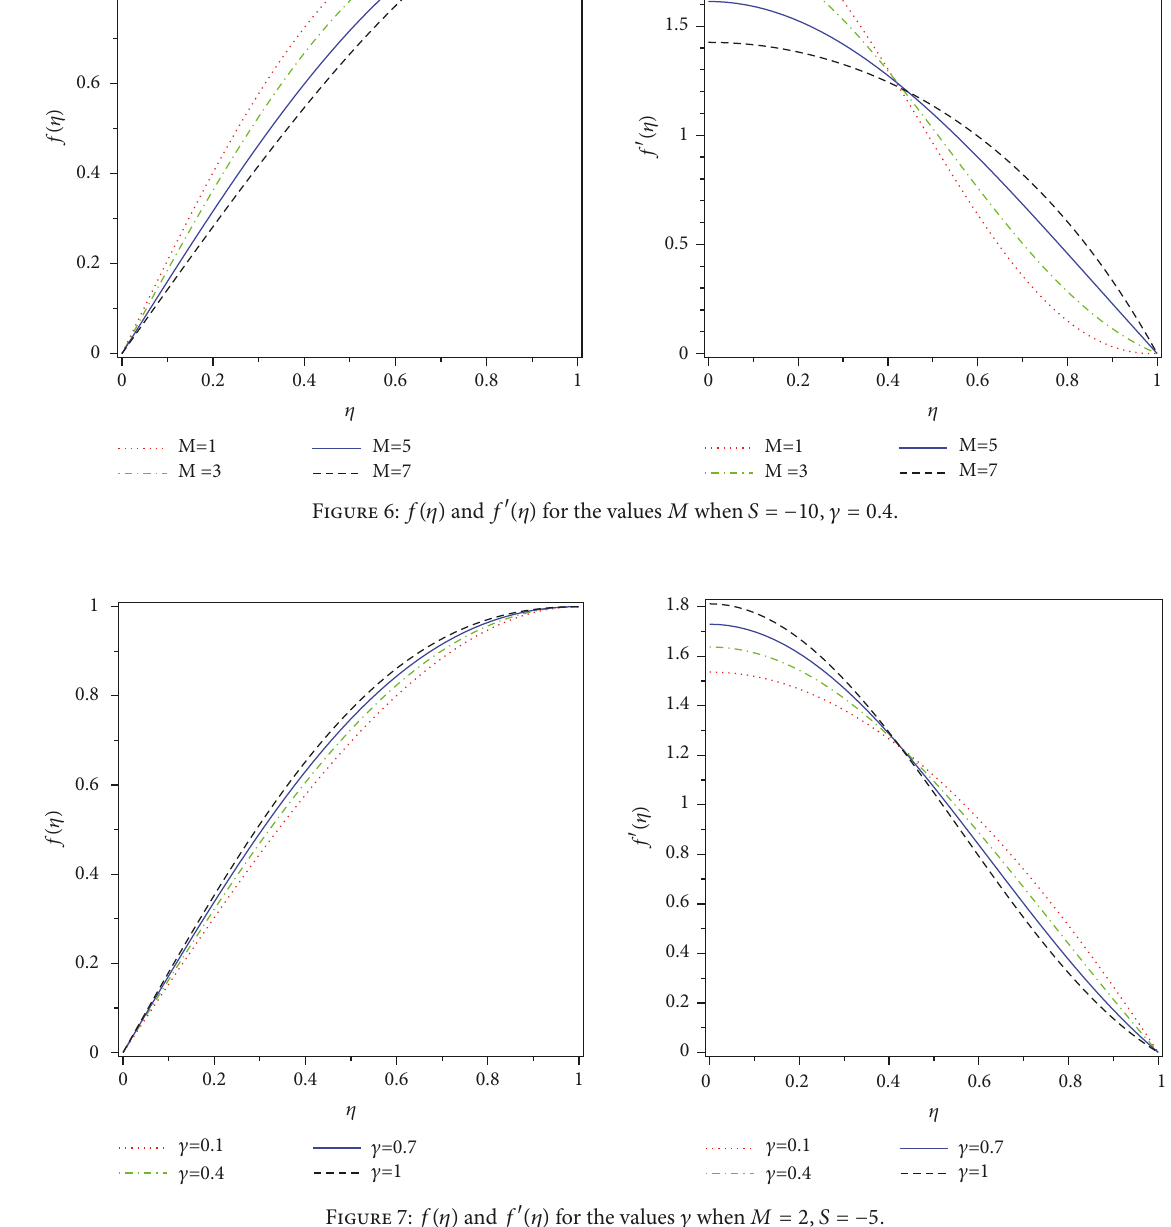
Figure 7: 𝑓(𝜂) and 𝑓 󸀠 (𝜂) for the values 𝛾 when 𝑀 = 2 , 𝑆 = −5